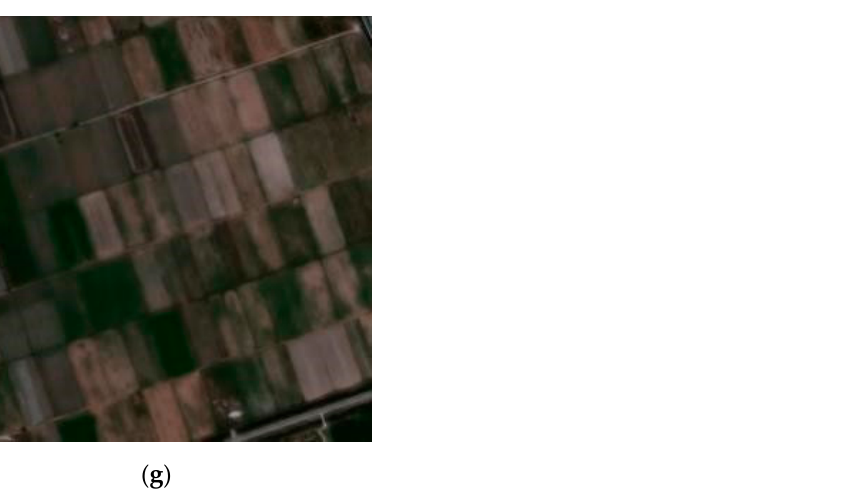
Figure 6. Simulated results for the Worldview-2 dataset. ( a ) Ground truth; ( b ) PCA; ( c ) SFIM; ( d ) MTF-GLP; ( e ) PNN; ( f ) DiCNN; ( g ) proposed.